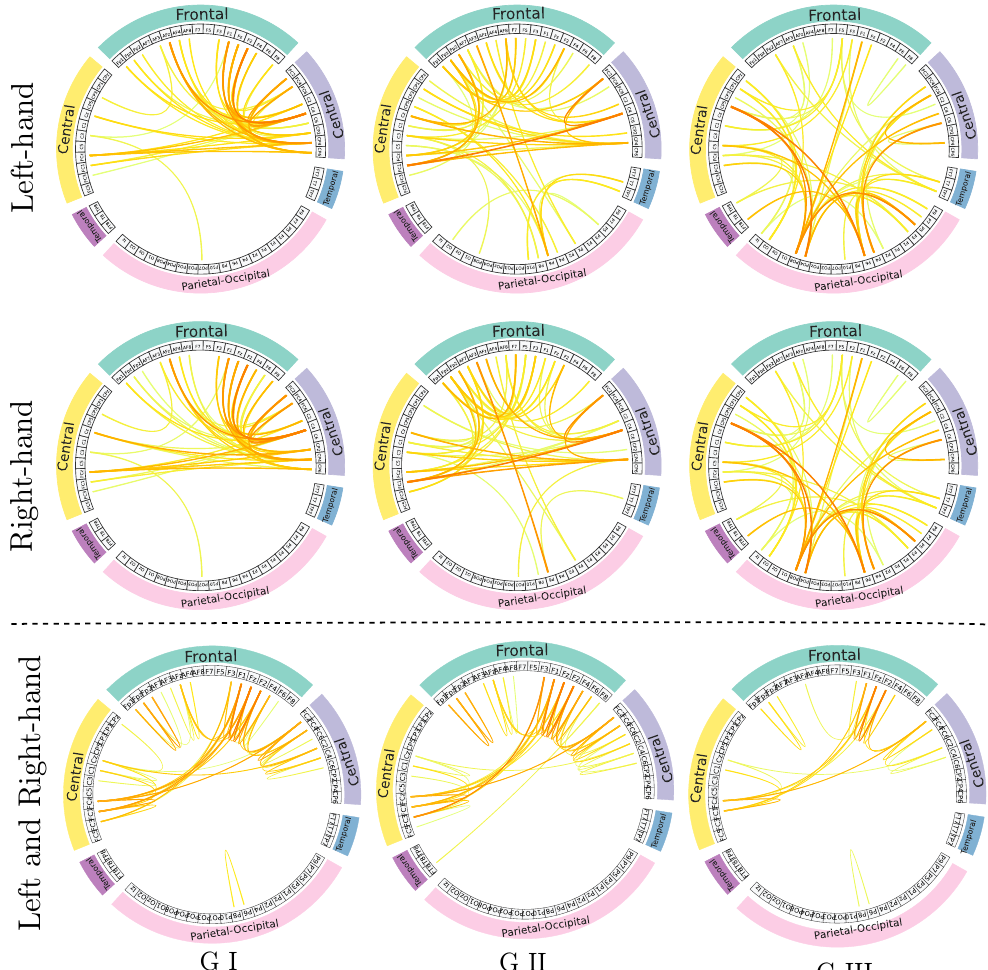
Figure 10. Graphical representation of the brain Gaussian Functional Connectivity estimated across each cluster of individual motor skills. Connectograms of each MI task ( top and middle rows ) are computed without the Komolgorov-Smirnov test and conducting the hypothesis test ( bottom row ). The GFC set is calculated at the 90 percentile of normalized relevance